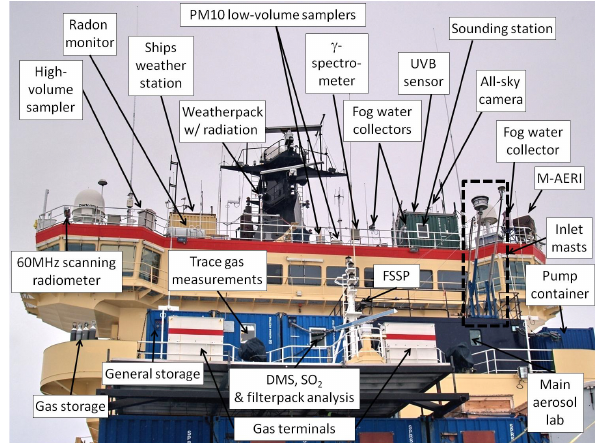
Fig. 5. Photograph from Oden ’s foredeck showing the location of the surface-based remote-sensing systems. The dual-wavelength radiometer and the NOAA ceilometer are obscured behind the remote-sensing container.